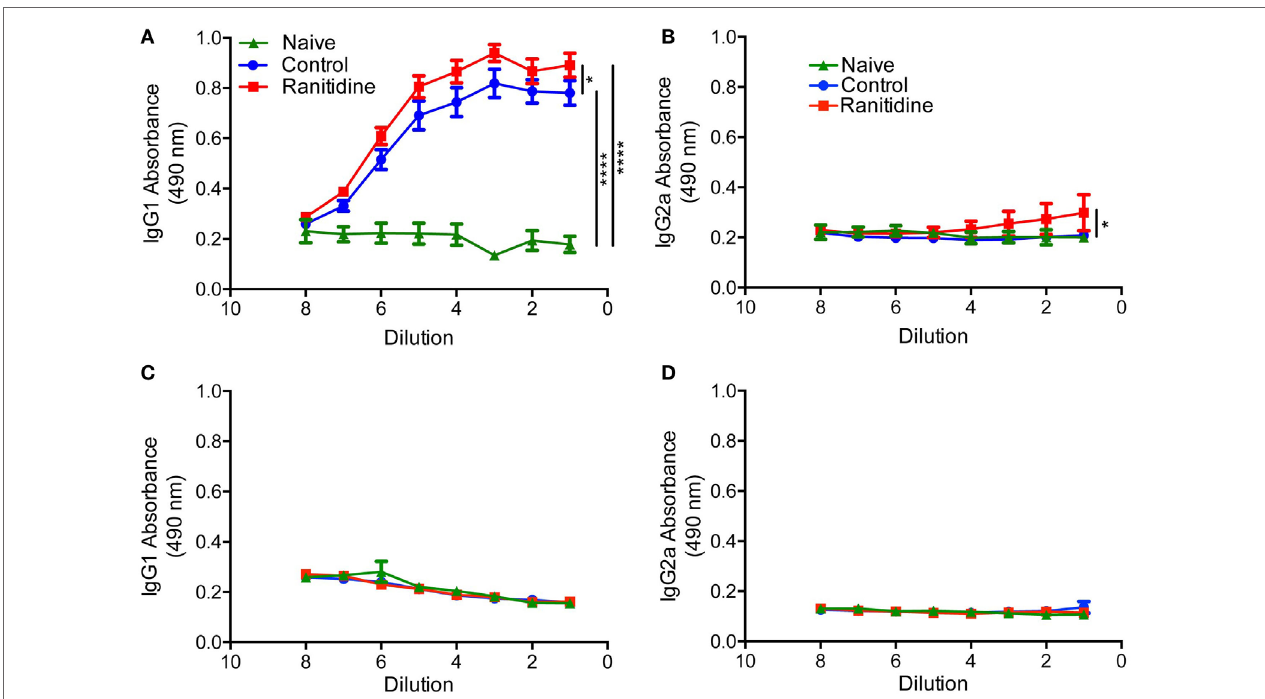
FigUre 4 | Ranitidine enhanced anti-OVA IgG2a and IgG1 antibody levels in OVA-Alum immunized naïve C57BL/6 mice but not in B16-OVA tumor-bearing mice. C57BL/6 mice were immunized and boosted with OVA with alum as an adjuvant (a,B) . C57BL/6 mice (ranitidine-treated or non-treated) were implanted with OVA-expressing B16 tumor cells (c,D) . After 18 days, the plasma from the mice were serially diluted and enzyme-linked immunosorbent assay was used to detect OVA-specific IgG1 (a,c) and IgG2a (B,D ). Data points represent mean ± SEM of 12 mice. Significance was assessed using two-way ANOVA followed by uncorrected Fisher’s LSD multiple comparisons. * p < 0.05 and **** p < 0.0001.